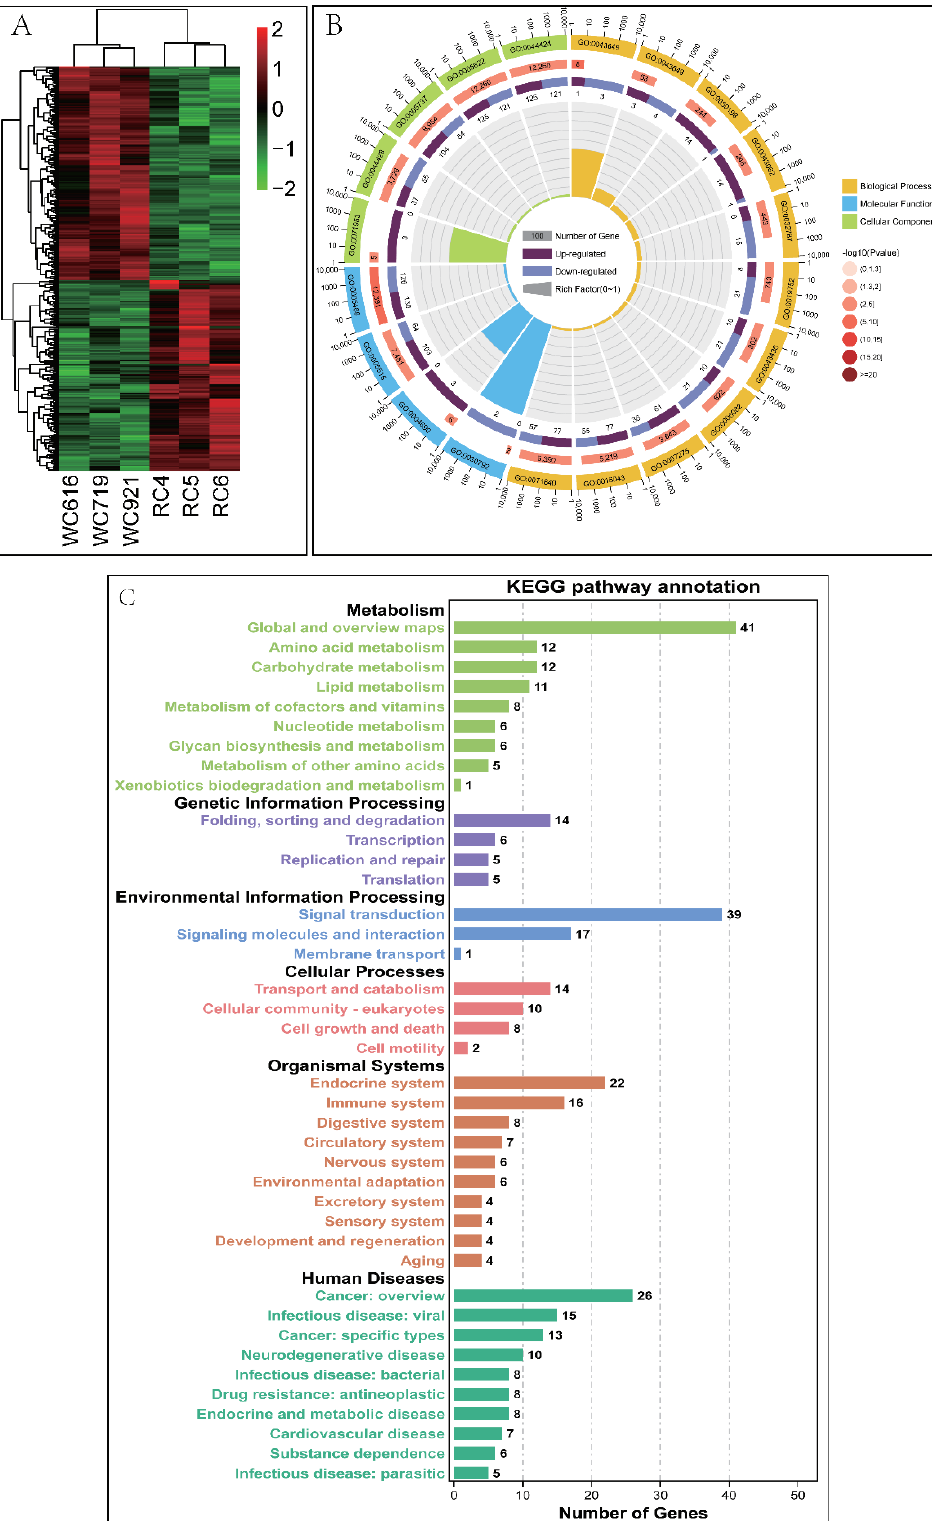
Figure 1. Differential mRNAs expression in Longissimus dorsi muscles between Japanese black cattle (Wagyu) and Chinese Red Steppe cattle. ( A ) Heat map of differentially expressed genes (DEGs); ( B ) the top 20 Gene Ontology (GO) terms by ascending order of corrected p value (BP: biological process; MF: molecular function; CC: cell composition); ( C ) the top 20 KEGG pathways listed by ascending order of corrected p -value .